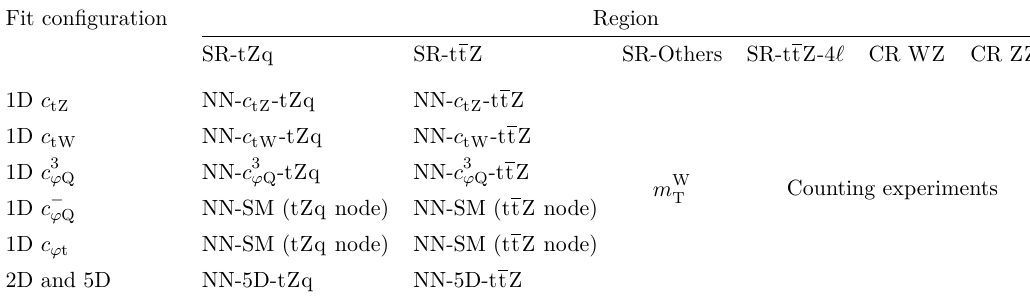
Table 5 . Observables used in each region for the different fits. The NN-SM is trained to separate different SM processes, while the other NNs are trained to identify new effects arising from one or more EFT operators, as described in section 7.